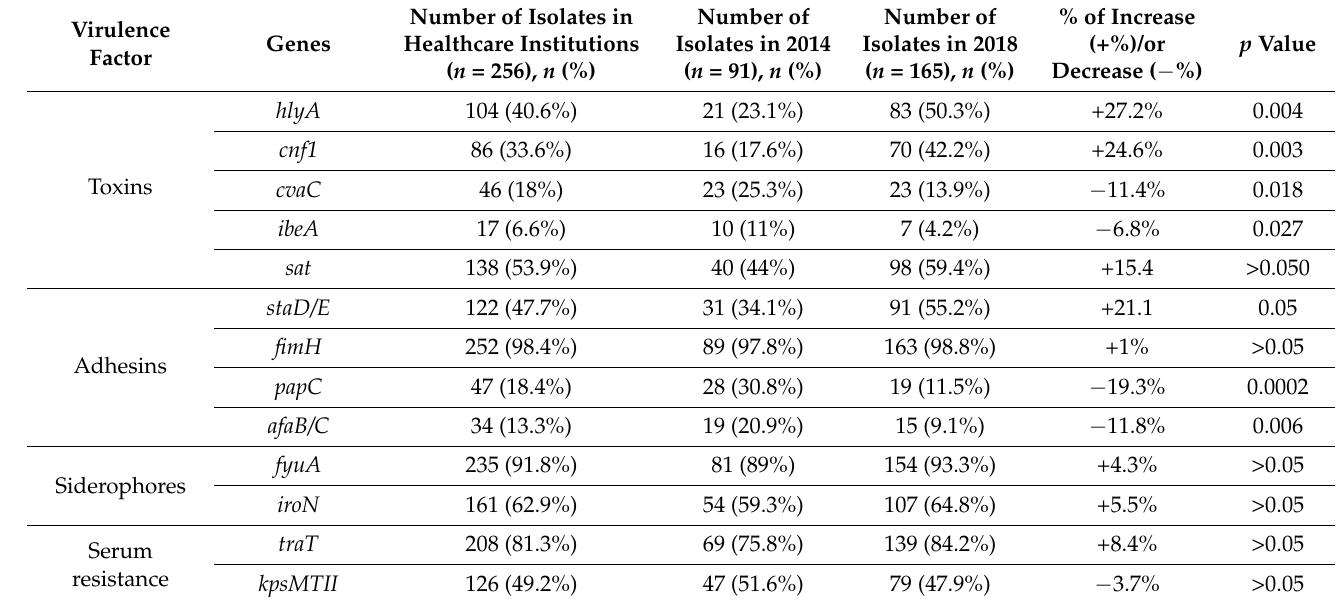
Table 3. Distribution of virulence genes at different healthcare